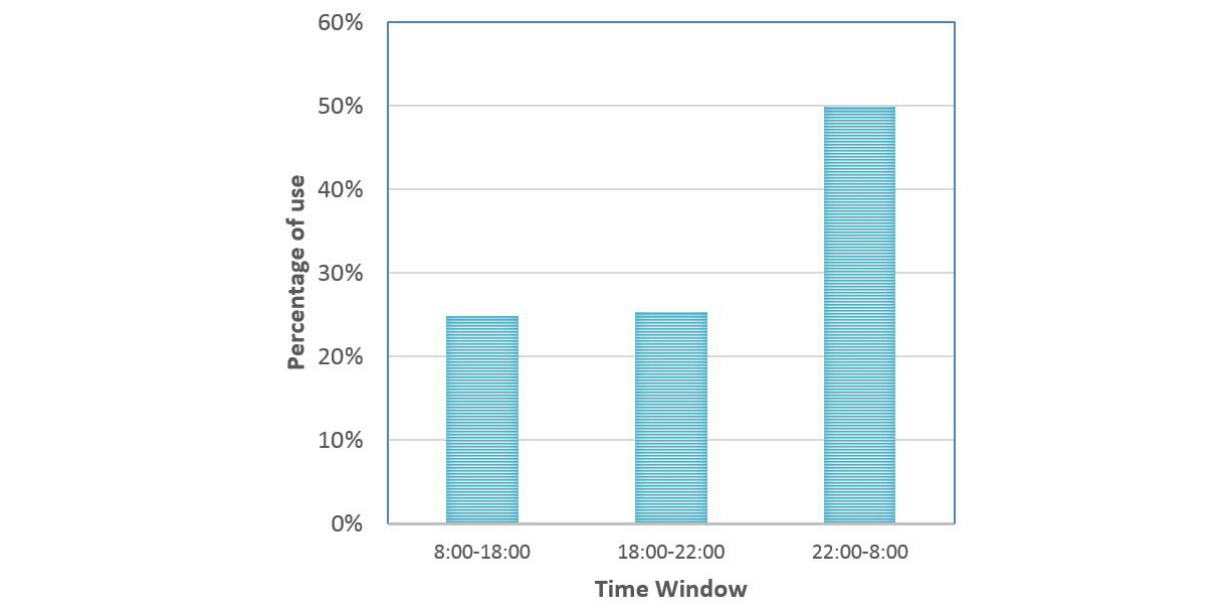
Figure 5. 7Cups use by daily time windows.